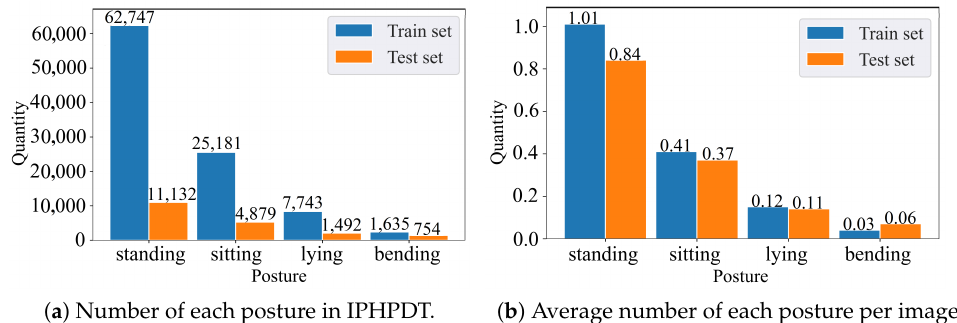
Figure 4. ( a ) shows the number of each human posture in the train set and test set on the IPHPDT dataset, and ( b ) shows the average number of each human posture per image in the train set and test set on the IPHPDT